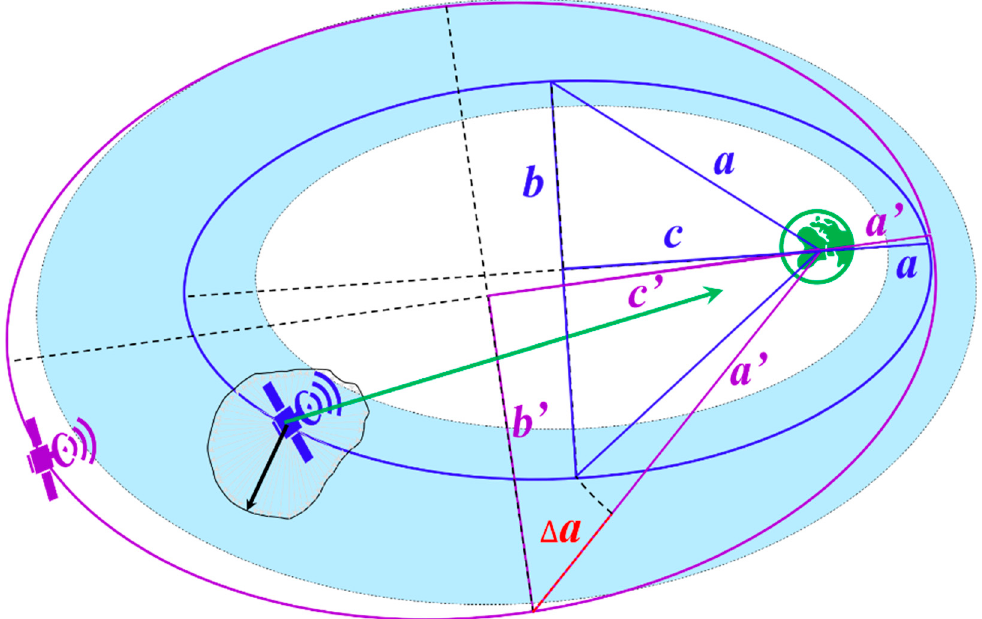
Figure 2. Schematic diagram of satellite orbit drift due to various perturbations from multiple planets and spacecraft. In Figure 2, the green circle denotes the Earth, which is the focal point of satellite orbits. The initial orbit of satellites is shown the elliptical blue curve, line a is the orbital semimajor axis, line b is the orbital semiminor axis, and line c is the half focal length of the satellite orbit. The light blue part denotes the normal range of satellite orbits. When satellites deviate from the normal orbit range, they can be adjusted by orbit maneuvering, using their propulsion system. The green arrow denotes the instantaneous gravity force acting on satellites from the Earth. The black arrow denotes the instantaneous joint forces from multiple planets acting on satellites, which leads to satellites tending to gradually deviate from their normal orbital range. The shape of the satellite orbits also changes